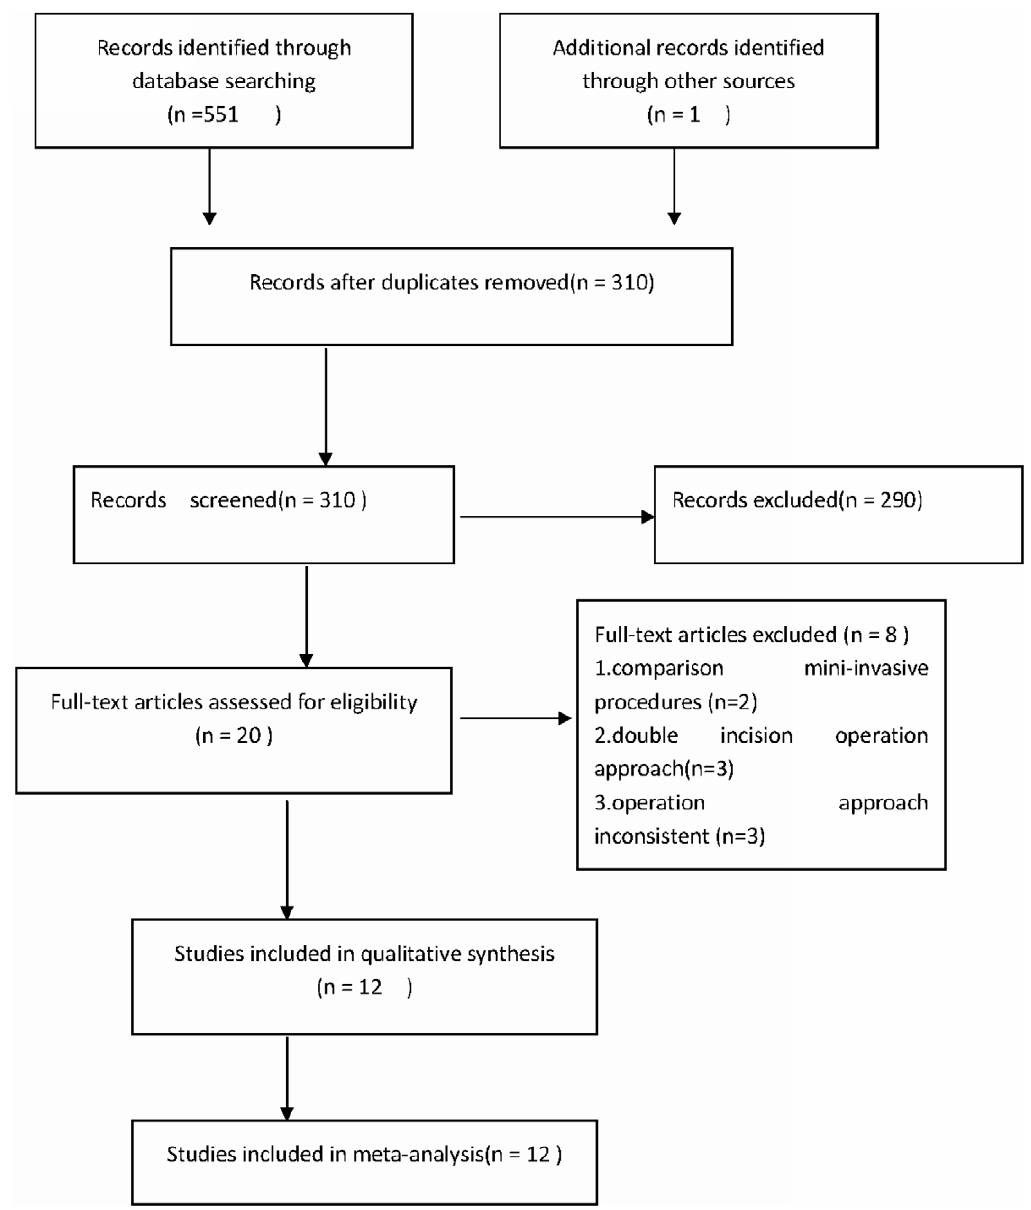
Figure 1. The process of identifying relevant studies is summarized.